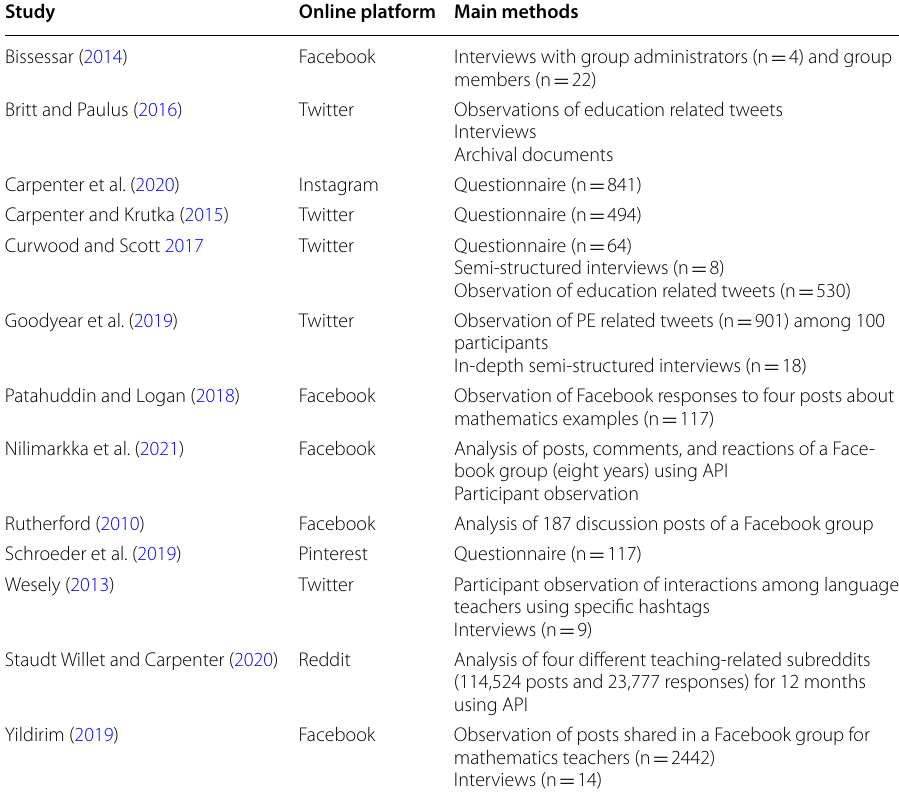
Table 1 Overview of relevant studies on online teacher communities on SNSs